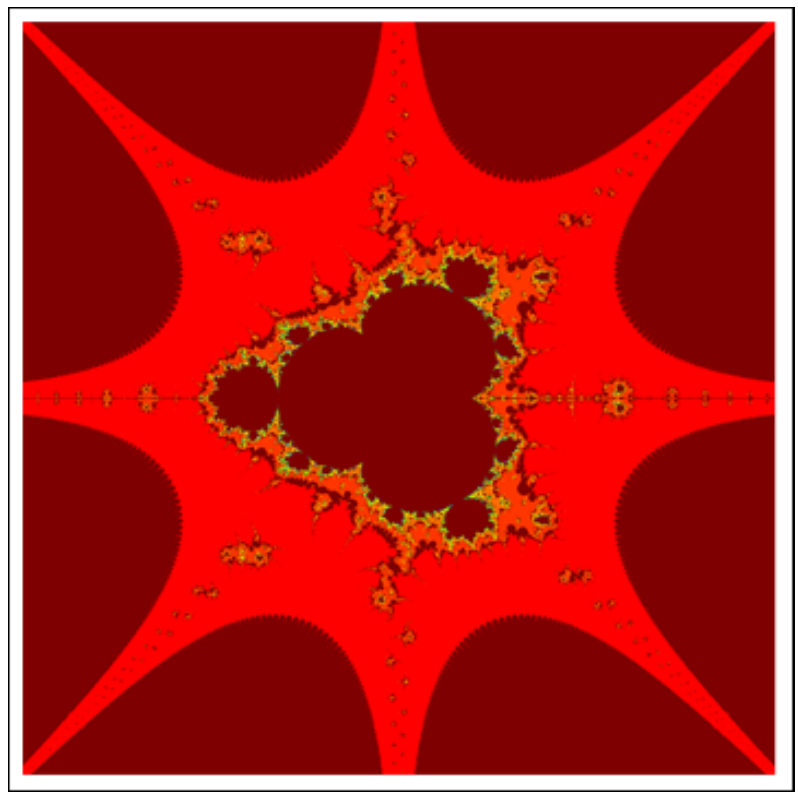
Figure 24. M-set for τ ( z ) = sin ( z 4 ) + c via DKIS. The image execution time is 528.625 s.